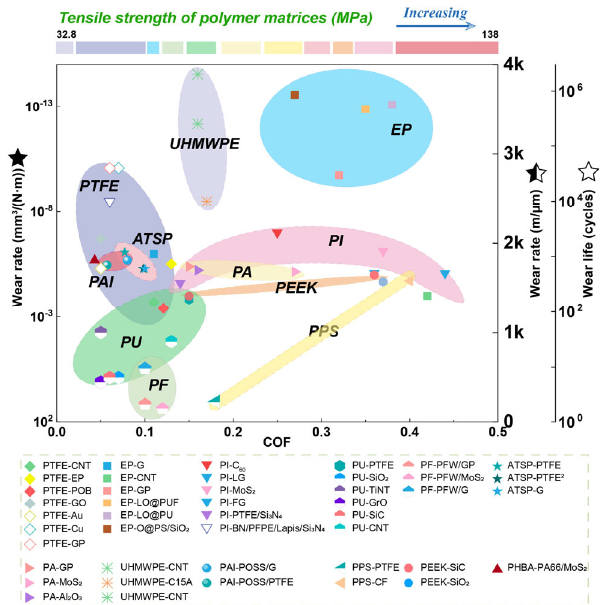
Fig. 18 Comparison of the tribological properties of different polymer matrices and different fillers [227]. Reproduced with permission from Ref. [227], © The author(s),